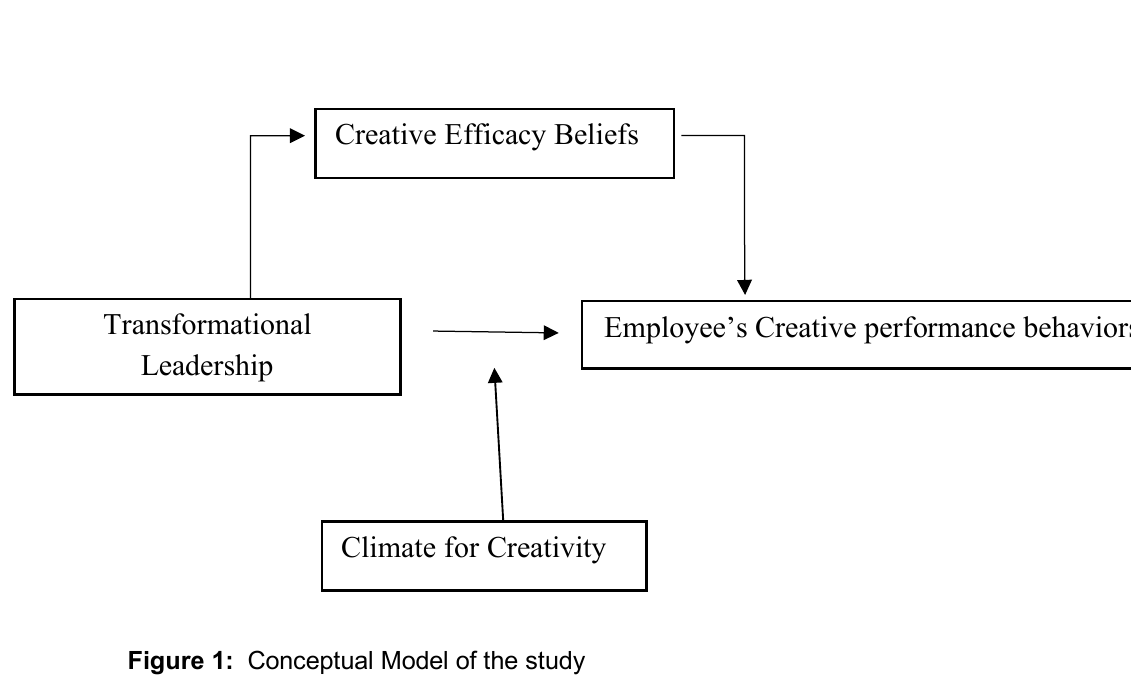
Transformational